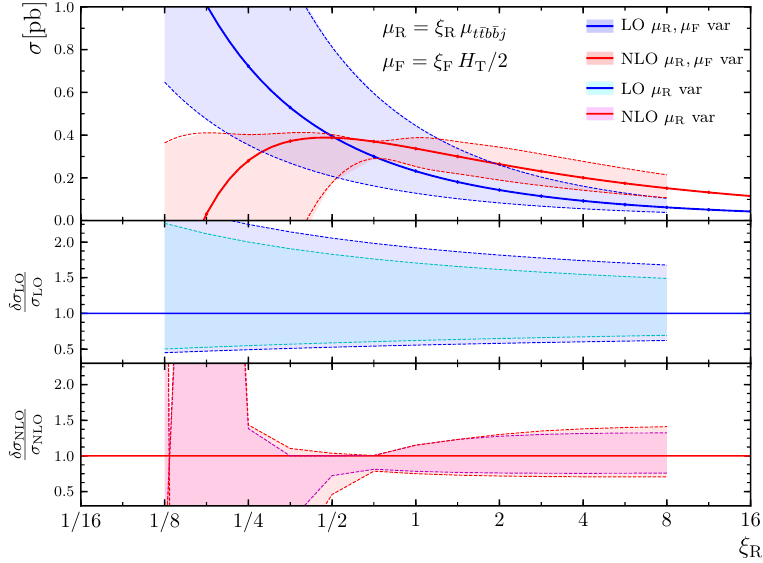
Figure 4. Cross sections at p s = 13 TeV in the ttbbj phase space. Predictions at LO (blue) and NLO (red) with scales (cid:22) R = (cid:24) R (cid:22) and (cid:22) F = H T = 2 are plotted as a function of the renormalisation t (cid:22) tb (cid:22) bj scale factor (cid:24) R . The main frame presents absolute predictions and corresponding 7-point factor- two variations of (cid:22) R and (cid:22) F , which are shown as uncertainty bands. The relative impact of such variations at LO and NLO is displayed in the two ratio plots, which show also a second uncertainty band corresponding to pure factor-two variations of (cid:22) R at (cid:12)xed (cid:22) F = H T =